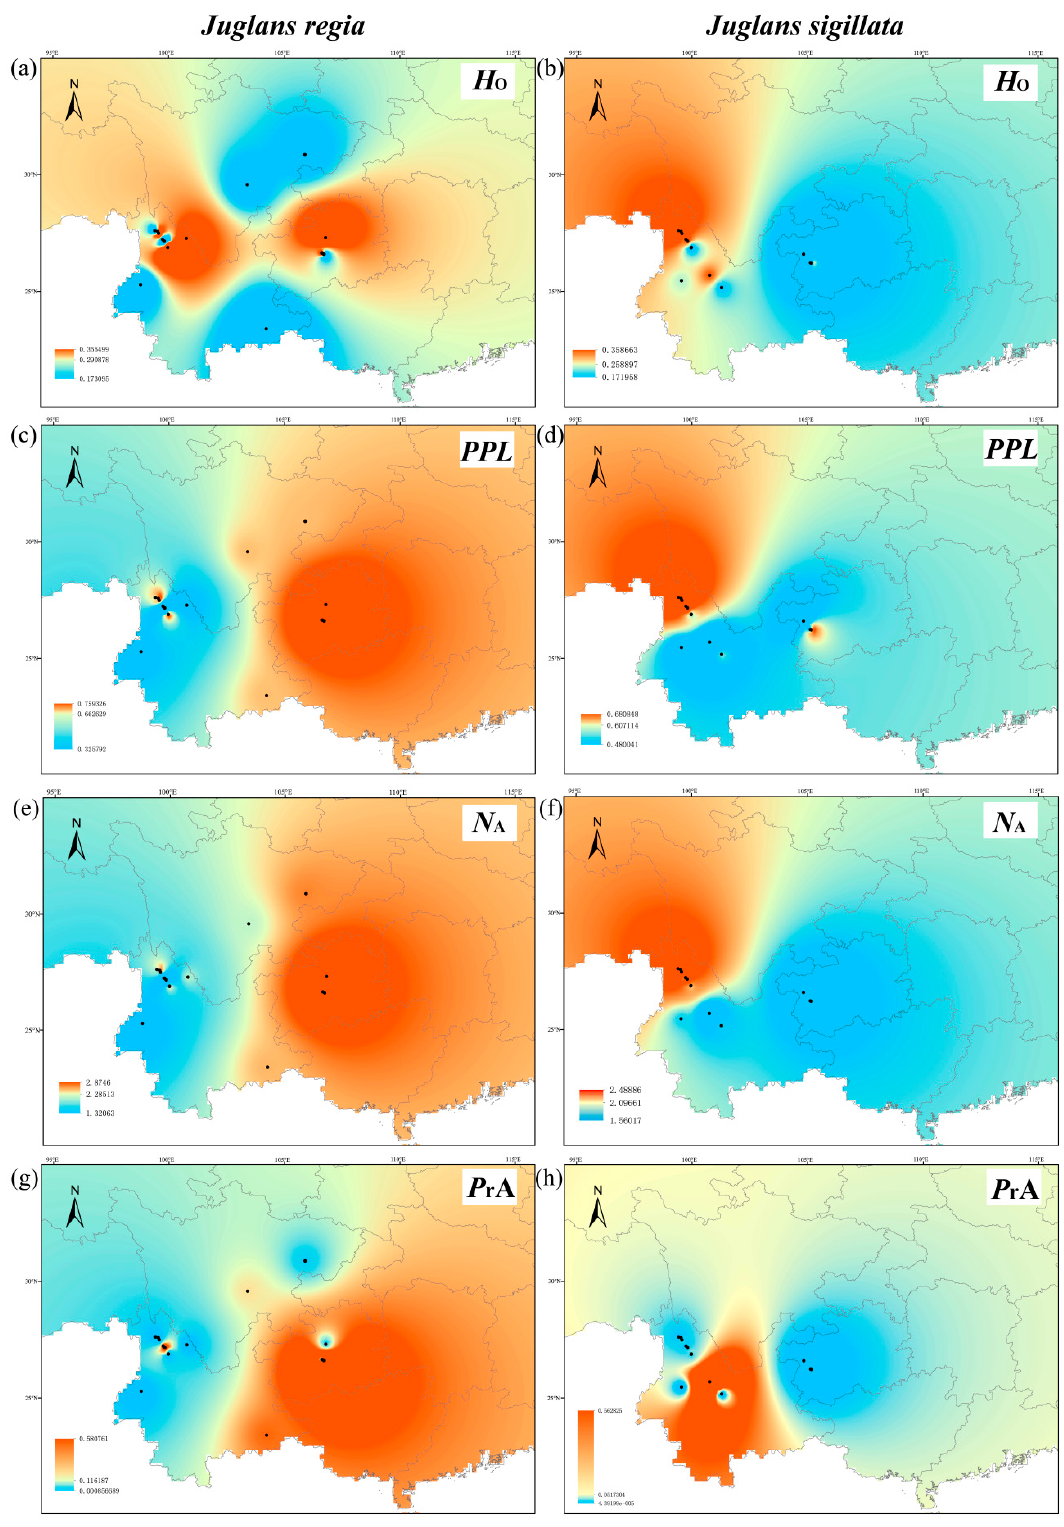
Figure 4. Genetic diversity maps of 15 Juglans regia and 13 J. sigillata populations (black dots) in China: IDW interpolation of ( a ) observed heterozygosity ( H O ) values of J. regia , ( b ) observed heterozygosity ( H O ) values of J. sigillata , ( c ) Percentage of Polymorphic Loci ( PPL ) values of J. regia , ( d ) Percentage of Polymorphic Loci ( PPL ) values of J. sigillata , ( e ) the Number of Alleles ( N A ) values of J. regia , ( f ) the Number of Alleles ( N A ) values of J. sigillata , ( g ) Private alleles ( PrA ) values of J. regia , and ( h ) Private alleles ( PrA ) values of J. sigillata .